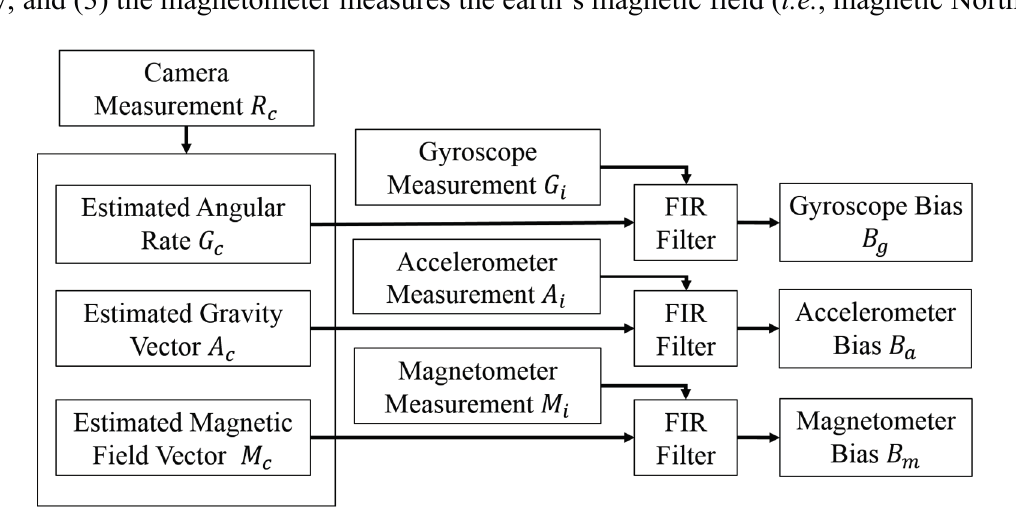
Figure 4. Bias modeling